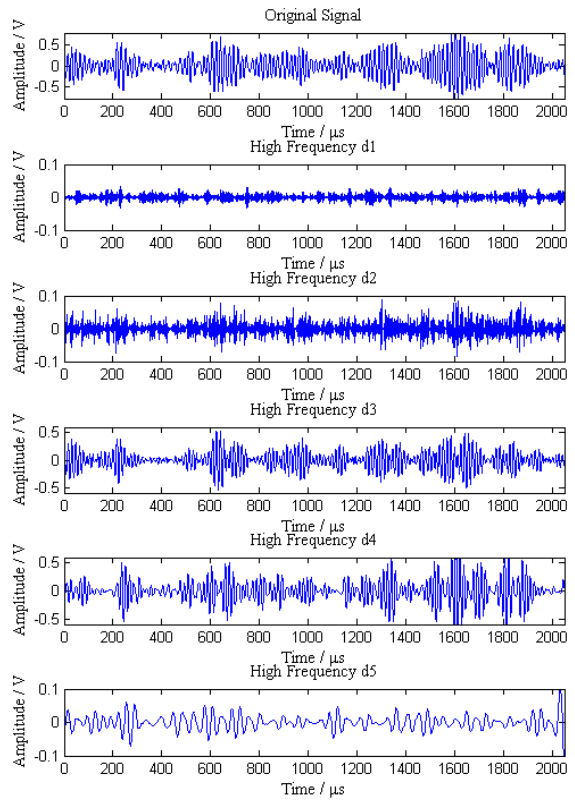
Figure 10. Signal decomposition of node